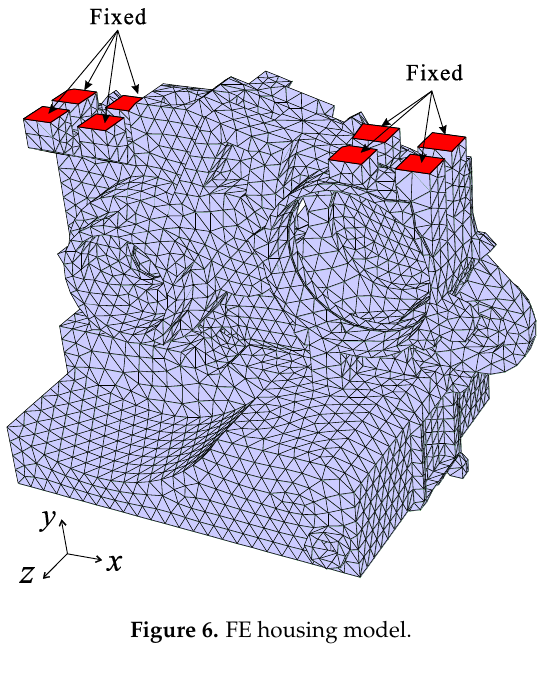
Appl. Sci. 2018 , 8 , x FOR PEER REVIEW